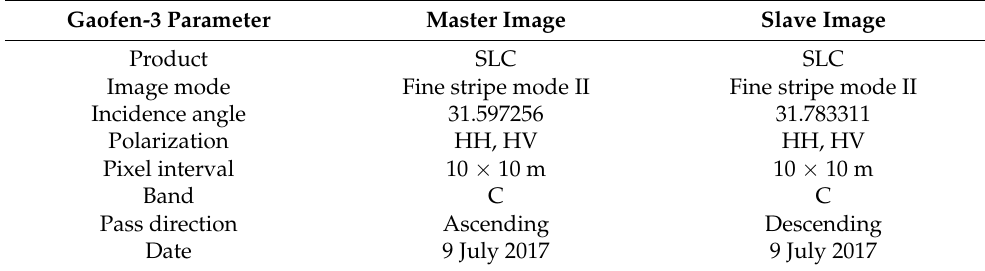
Table 1. Parameters for Gaofen-3.